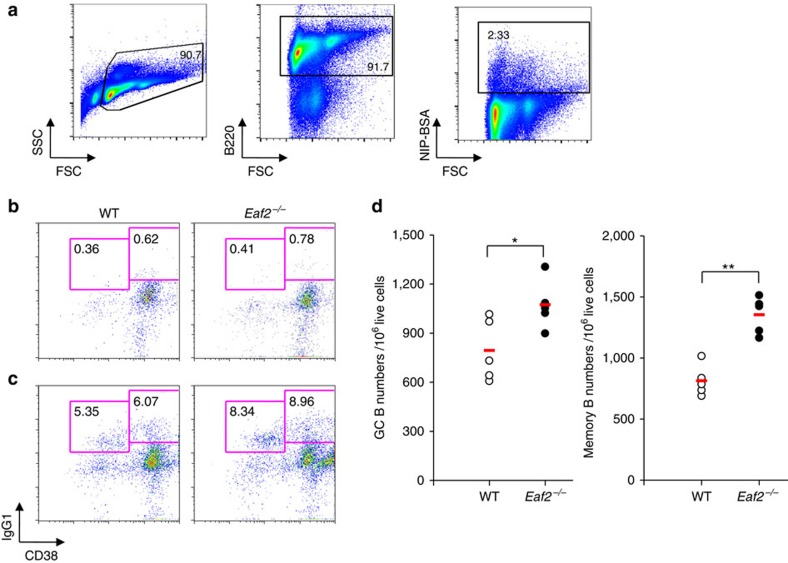
Increased frequency of Ag-specific GC and memory B cells after immunization.Spleen B cells were purified 2 weeks after immunization with NP–CGG and stained with FITC-labelled IgG1, PE-conjugated NIP26-BSA, APC-conjugated anti-CD38 and PE-Cy7-labelled anti-B220. GC B (NIP binding/B220+/IgG1dull/CD38dull) and memory B cells (NIP binding/B220+/IgG1high/CD38+) were enumerated. (a) Gating strategy for the analysis of GC B and memory B cells. The live B220+ NIP-binding cells were analysed for CD38 and IgG1 expression. (b) Before immunization. (c) Two weeks after immunization. Left panel, WT mice; right panel, Eaf2−/− mice. (d) The tabulated results of five pairs of WT and Eaf2−/− mice. Left, GC B cells; right, memory B cells. Open circles, WT mice; Solid circles, Eaf2−/− mice. The red bar indicates the mean of five mice. *P<0.05; **P<0.01 (unpaired t-test).